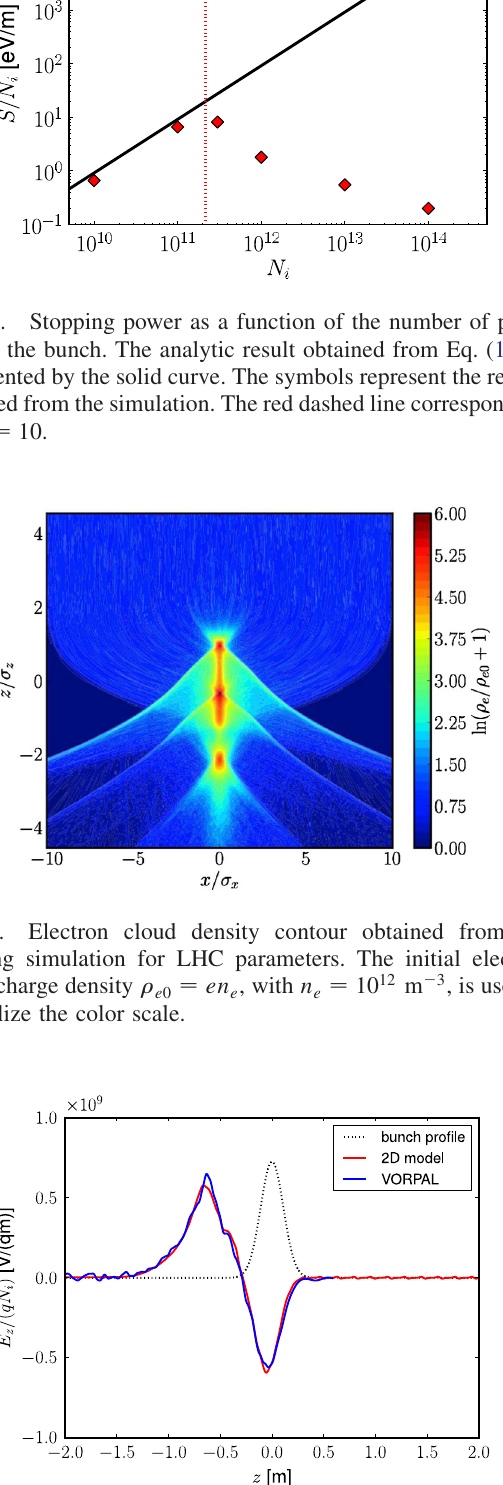
FIG. 3. Longitudinal electric field obtained from the 2D ES and the 3D EM simulations for n e ¼ 10 12 m (cid:2) 3